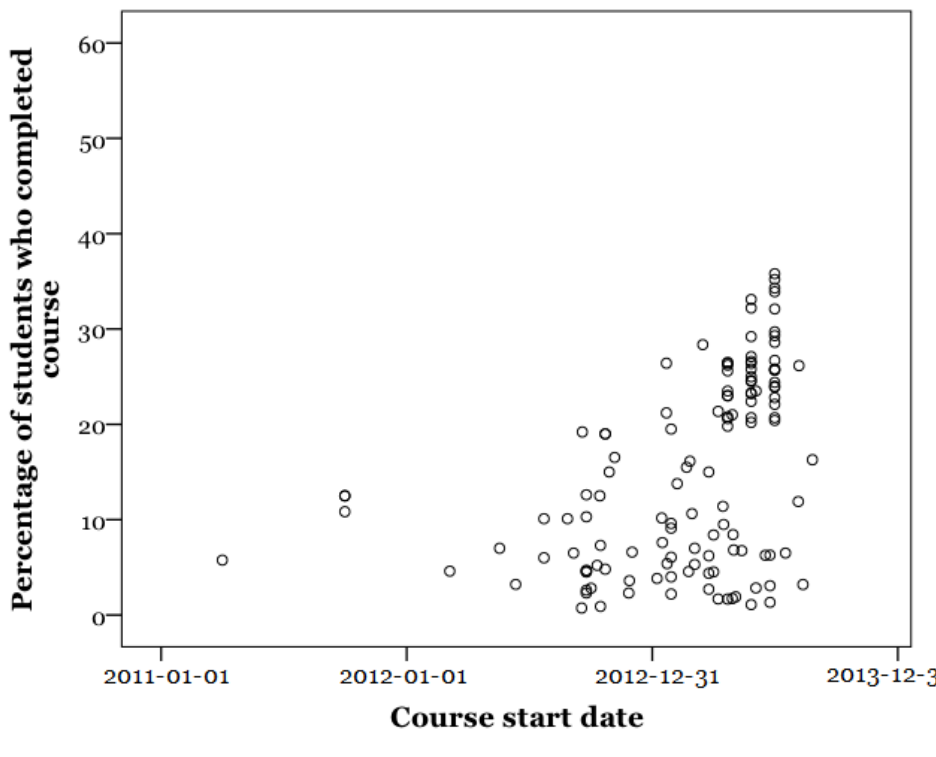
Figure 2. Scatterplot of percentage of students who completed courses plotted against course start date